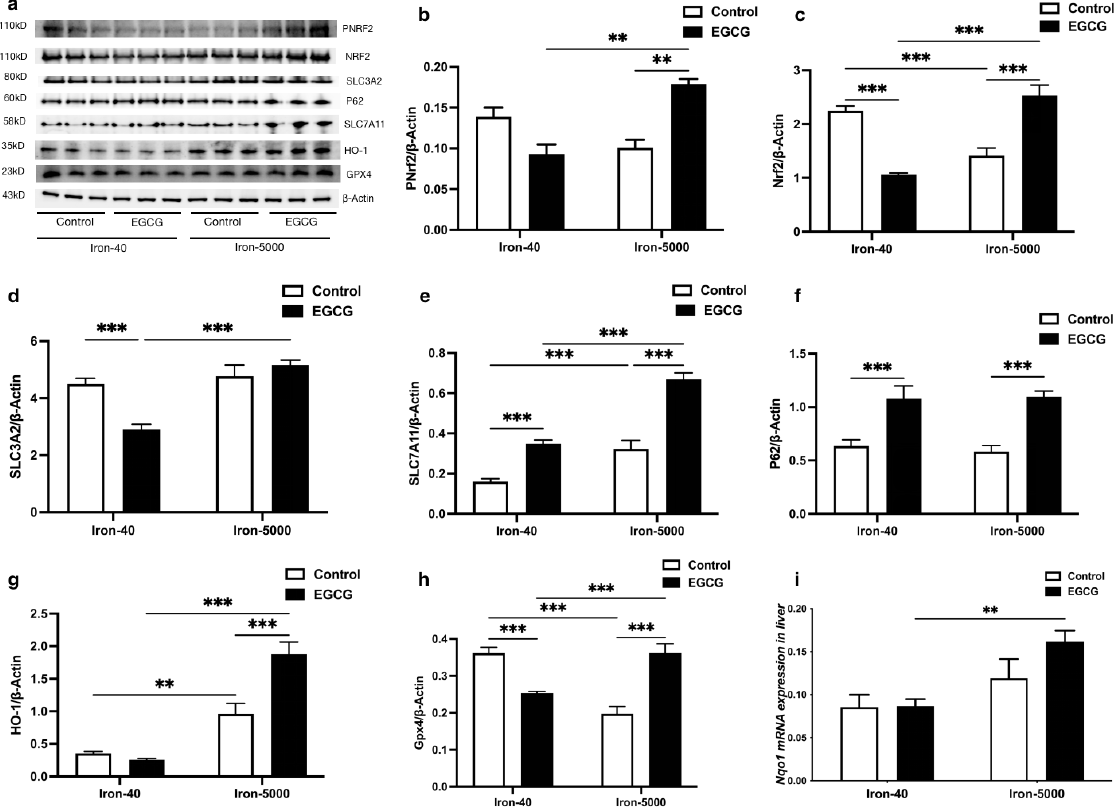
Figure 6. EGCG supplementation mitigates iron overload - induced oxidative damage by modulating antioxidant factors. ( a ) Western blot for the antioxidant-related protein expression ( n = 3). ( b – h ) Quantification of pNRF2, NRF2, SLC3A2, SLC7A11, P62, HO-1, and GPX4 in the mouse livers of each group ( n = 3). ( i ) mRNA expression of Nqo1 ( n = 10). The results of the two-way ANOVA are denoted by p -values, p < 0.01 (**), p < 0.001